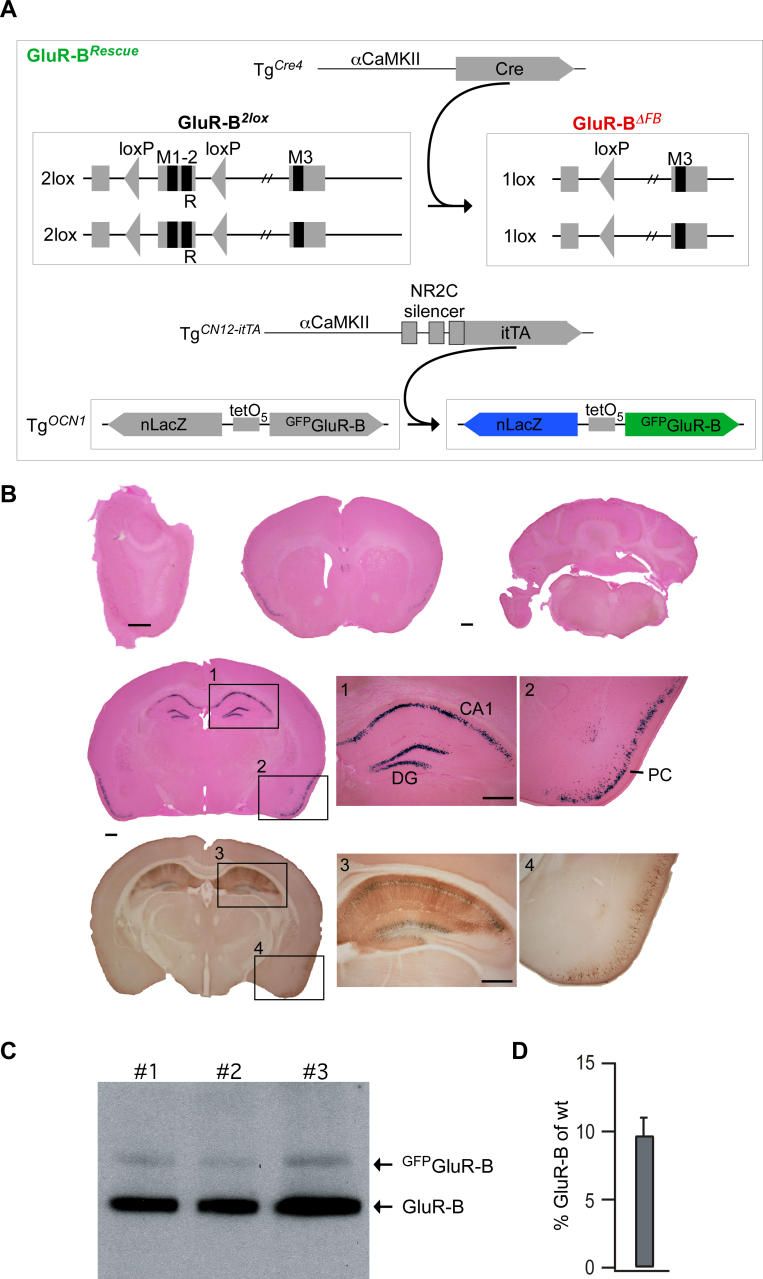
Specific Hippocampus and Piriform Cortex Expression of Transgenic GFPGluR-B(A) Schematic diagrams depicting forebrain-specific GluR-B deletion as in Figure 2A and itTA-dependent expression of GFPGluR-B and nuclear-localized β-galactosidase (nLacZ) in GluR-BΔFB mice (termed GluR-BRescue). GFPGluR-B and nLacZ are both encoded by TgOCN1, and itTA is controlled by a fusion of the NR2C silencer element [91] and the αCaMKII promoter (termed TgCN12-itTA [92]).(B) In coronal brain sections of mice positive for both transgenes (TgCN12-itTA and TgOCN1) β-galactosidase activity (blue, X-gal, counterstain by eosin) is restricted to hippocampal neurons in CA1, DG, and neurons in the piriform cortex. The same neurons show GFPGluR-B expression when analyzed in immunohistochemical sections with an antibody against GFP. Scale bars: 500 μm.(C) Immunoblot detecting endogenous GluR-B and transgenic GFPGluR-B in the hippocampus of three different mice (#1, #2, #3).(D) Relative quantification from (C) of transgenic GFPGluR-B compared with endogenous GluR-B in the hippocampus.